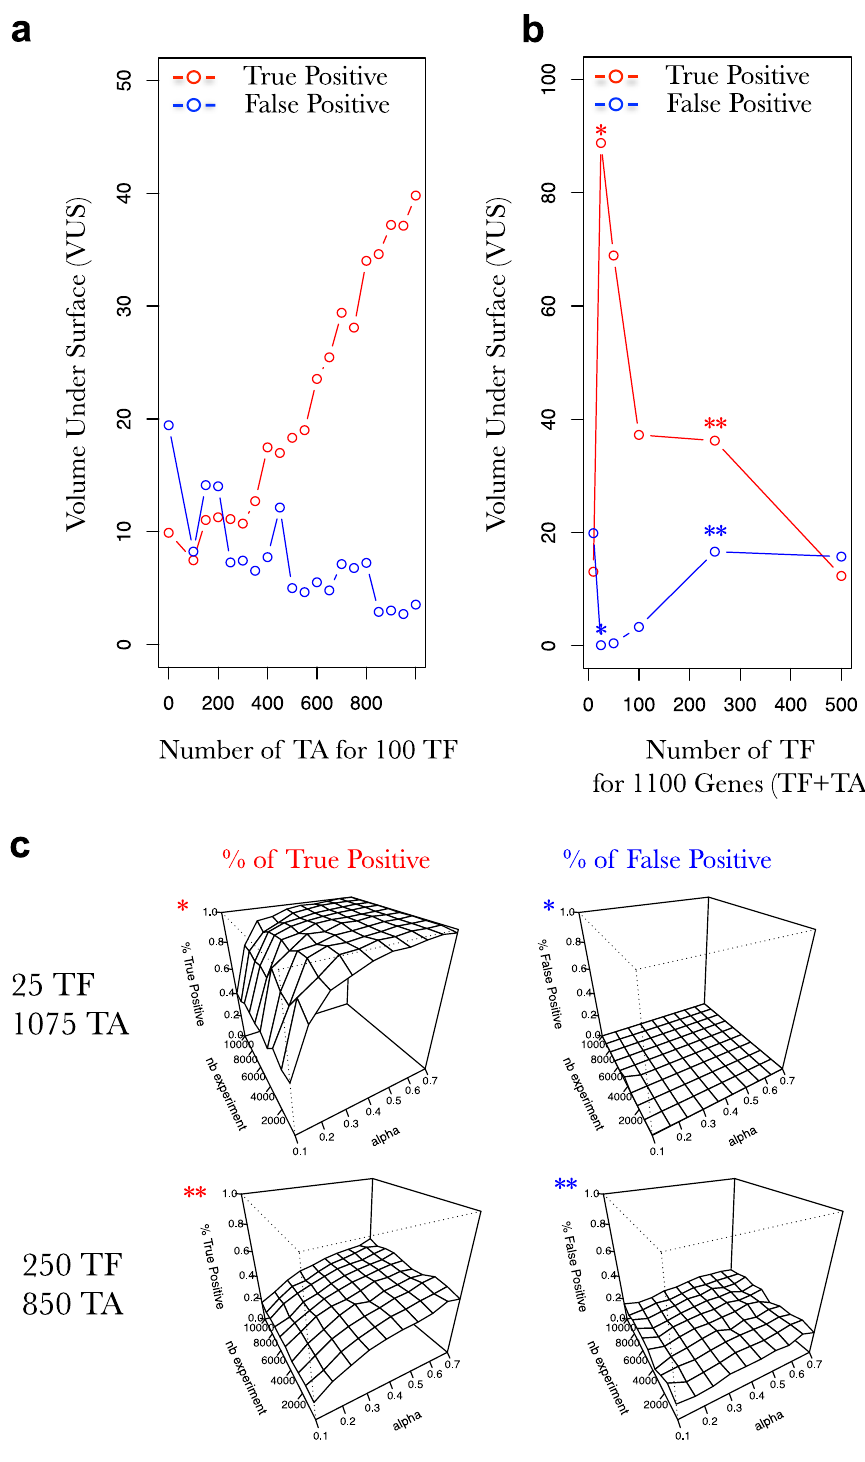
Fig. 8 Target genes (TA) are important for the accurate reconstruction of the network. a Progression of the volume under the surface computed for a progression in the number of TA for FRANK generated networks having a constant number of 100 TF. b Progression of the volume under the surface computed for a progression in the number of TA for FRANK generated networks having a constant number of genes (TA + TF = 1100). Red , % of True positive and blue , the % of false positive predicted connections in the network. Transcriptomic data kind: A 1 ; prior knowledge data kind rows . c Example of surfaces exploring the SVM accuracy (% of true positive on left and % false positive in right panels) to predict the connections in a FRANK generated network (25 TF, 1075 TA for the top 2 surfaces and 250 TF, 850 TA for the bottom two surfaces) using an increasing number of simulated gene expressions ( nb experiment; y axis) and an increasing fraction of the network as prior knowledge ( alpha [rows are used as prior knowledge]; x -axis). Percentage of true positive and false positive are evaluated based on predictions of the presence of an edge and its positive or negative in fl uence. The surfaces presented in c correspond to two particular points in the b noted by asterisks